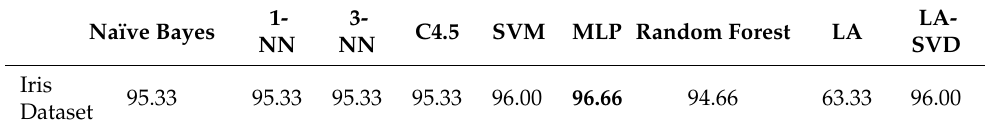
Table 2. Accuracy values updated with the result of the LA-SVD classifier. Naïve